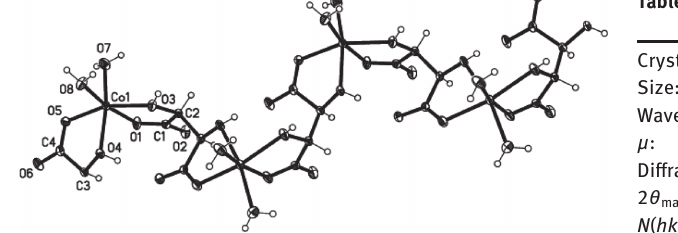
Table 1: Data collection and handling.